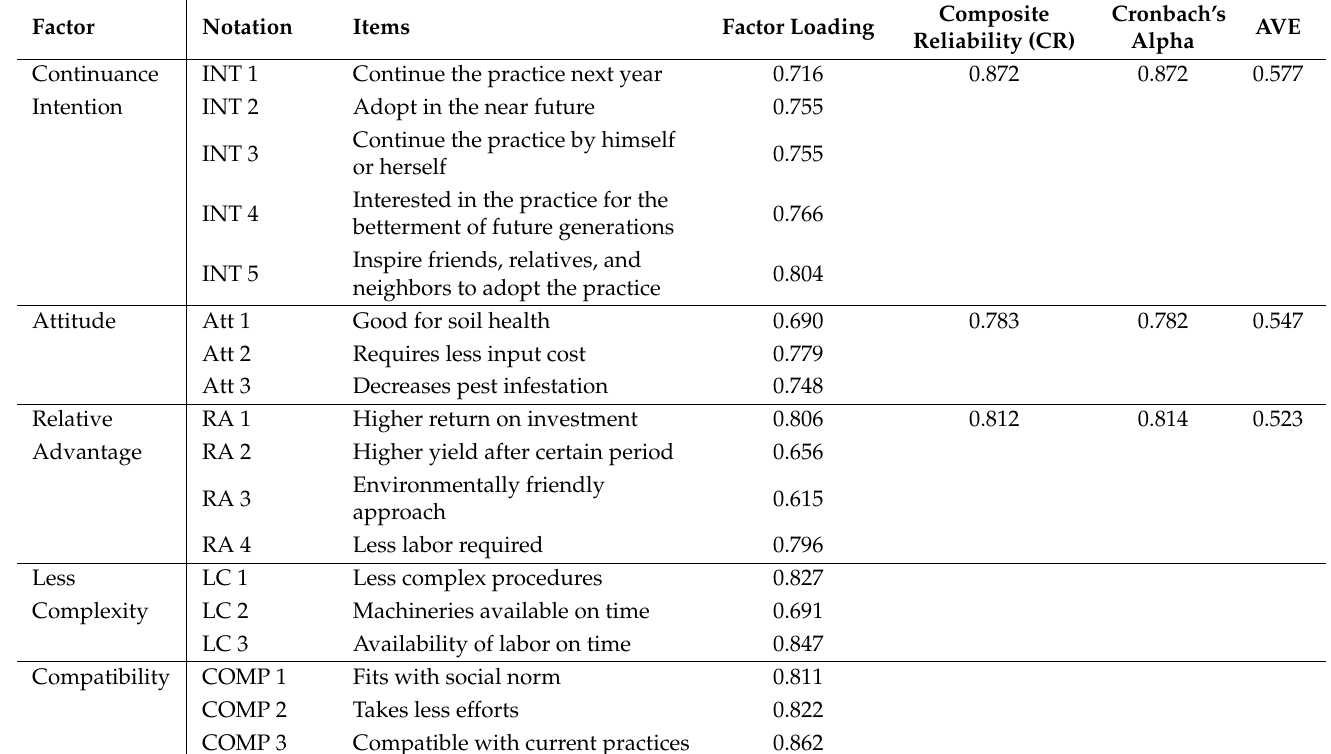
Table 7. Construct internal consistency, reliability, and